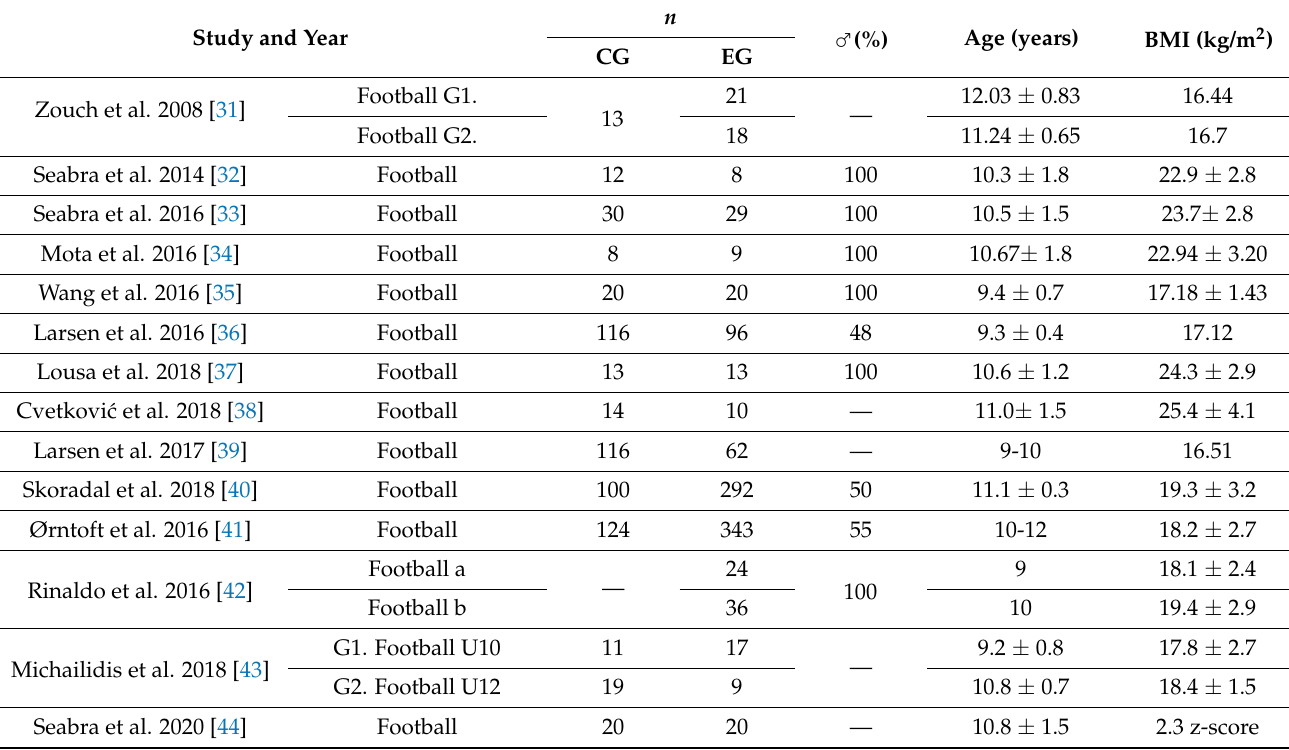
Table 1. Main participants characteristics of the studies included in the meta-analysis.